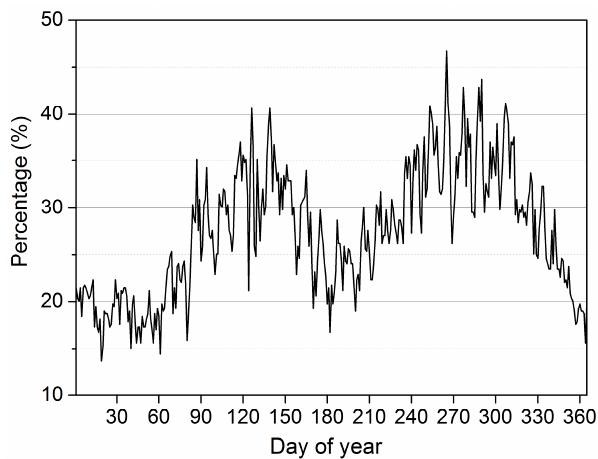
Figure 2. Twelve-year and 333-station averaged daily distribution (as percentage) of qualified Ta -predictor “pairs.”